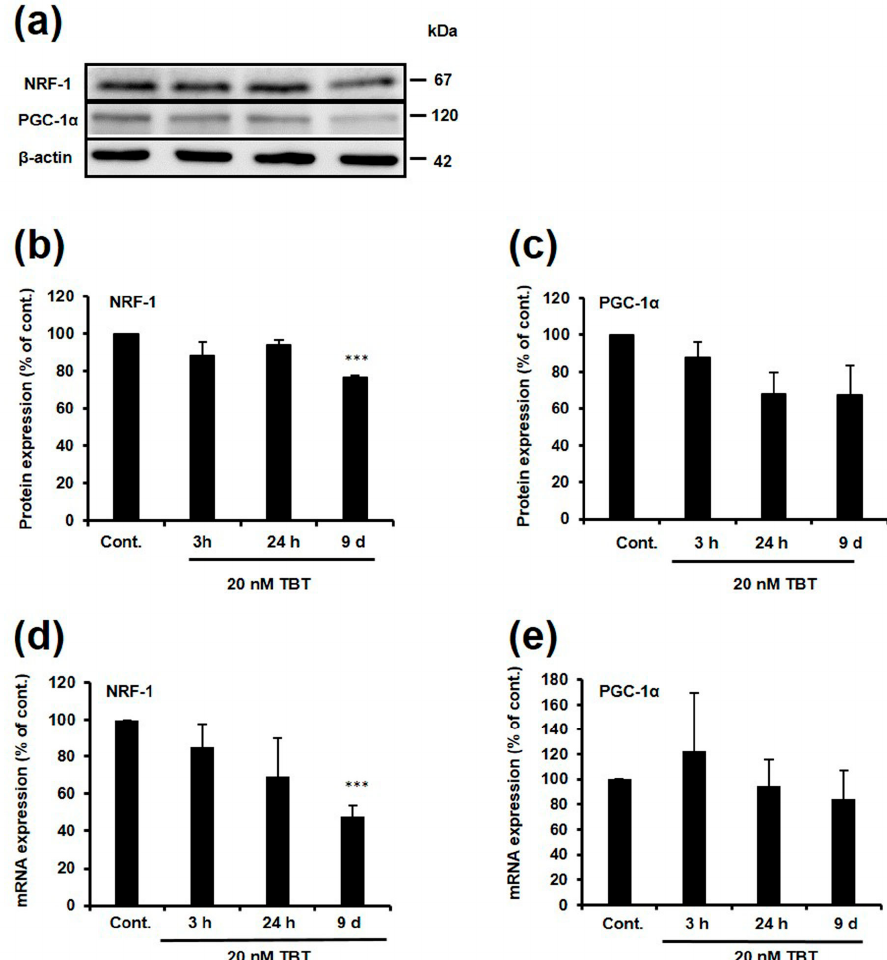
Figure 4. Effect of TBT on NRF-1 and PGC-1 α expression. ( a ) Cortical neurons were exposed to DMSO or 20 nM TBT for various times, then NRF-1 and PGC-1 α protein expression was detected by western blotting. Quantitative analysis of the NRF-1 ( b ) and PGC-1 α ( c ) protein expression was performed using Image J software, and protein levels were corrected based on β -actin protein levels. The data are expressed as the mean + S.E.M. ( n = 3). *** p < 0.001 vs. control. Cortical neurons were exposed to DMSO or 20 nM TBT for various times, and then NRF-1 ( d ) and PGC-1 α ( e ) mRNA expression was measured by real-time PCR. The data are expressed as the mean + S.E.M. ( n = 4). *** p < 0.001 vs. control.